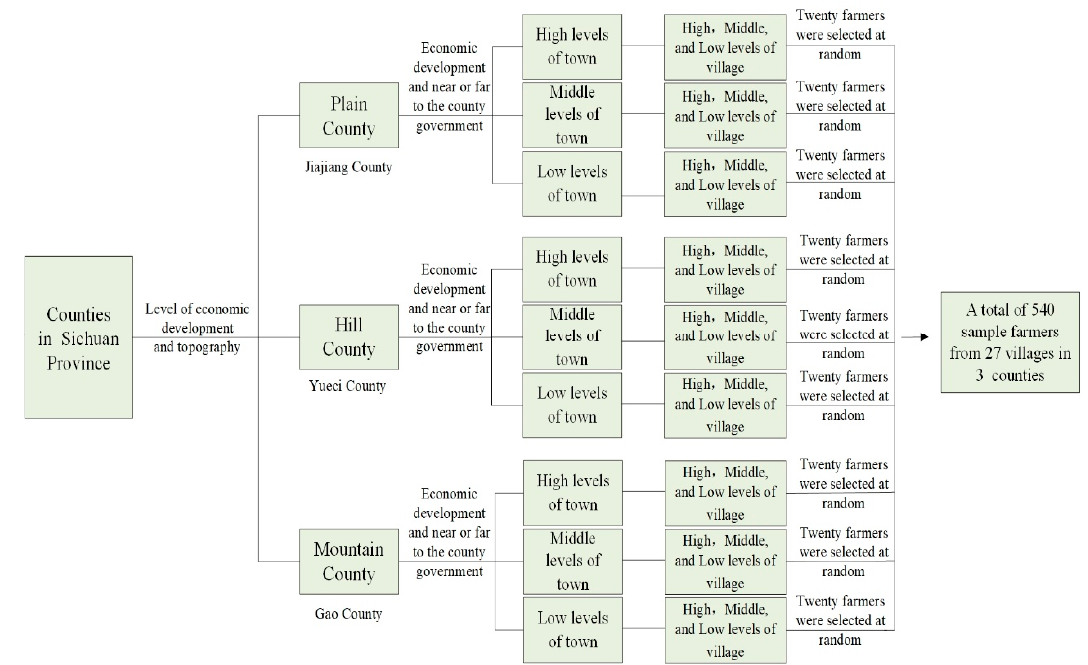
Figure 2. Survey sampling process.